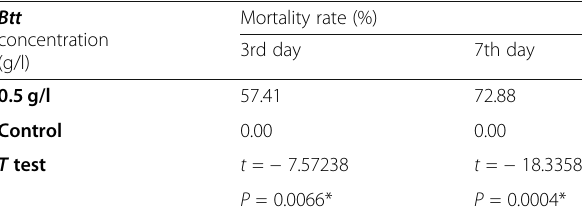
Table 2 Effects of Bacillus thuringiensis var. thuringiensis against Syllepte derogata larvae under field